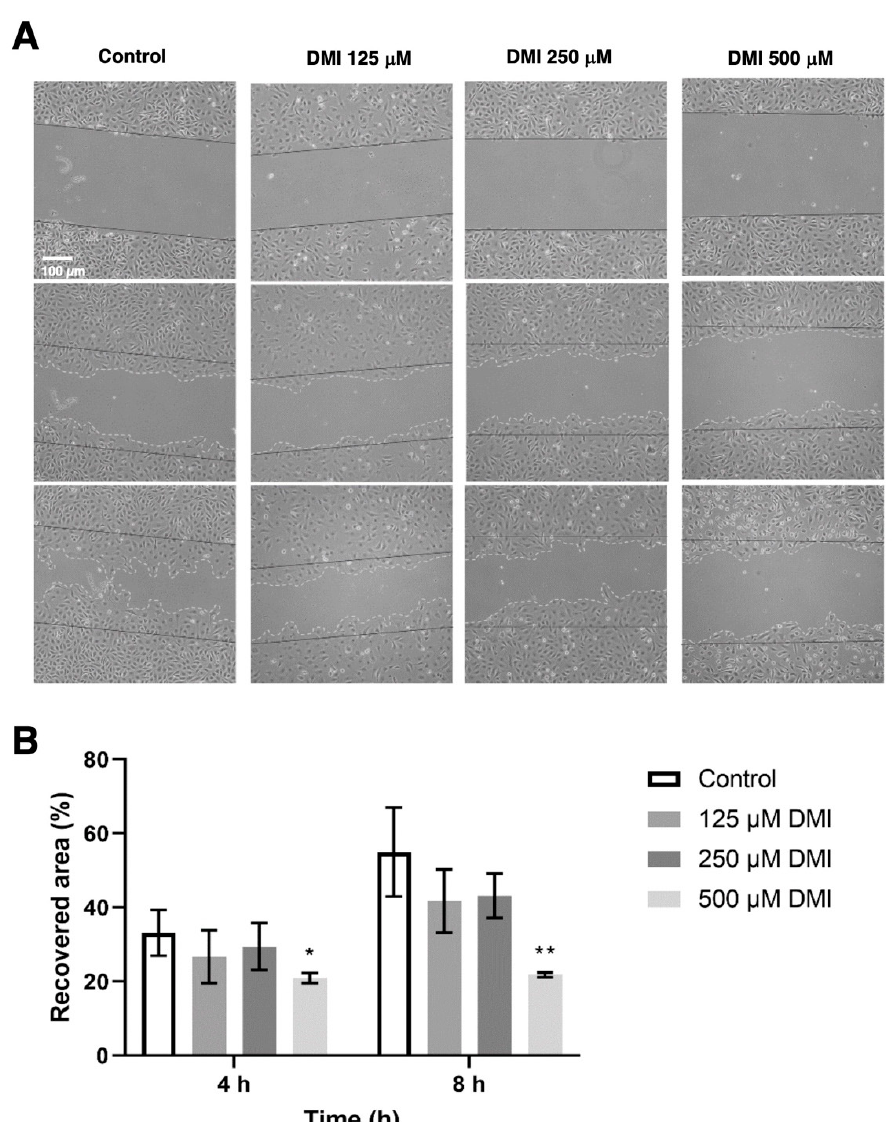
Figure 5. Effect of DMI on endothelial cell migration in vitro. ( A ) Representative images of control and DMI-treated BAECs at the indicated times of incubation. The initial area is indicated in the images with black continuous lines. The recovered area by the cells is indicated with grey dashed lines. ( B ) Quantification of the recovered area. Data are expressed as means ± S.D. of four independent experiments. * p < 0.05, ** p < 0.01 versus control.